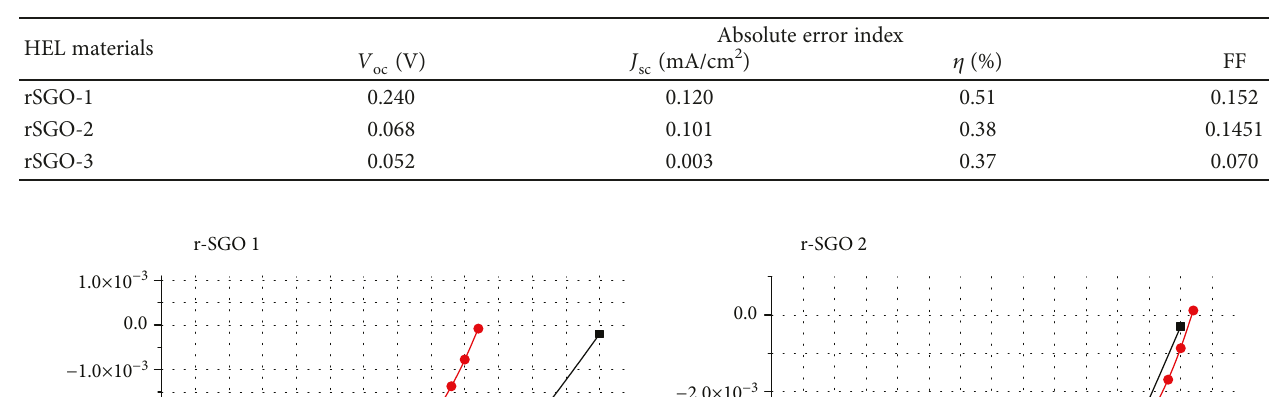
Table 4: Relative error between the experimental and modelled results.